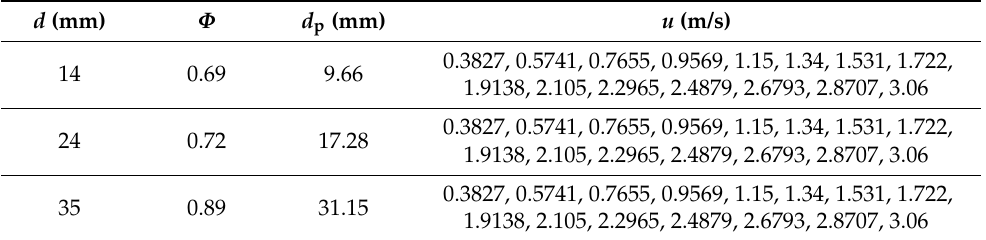
Table 1. Particle parameters and change in the ranges of the gas superficial velocity.